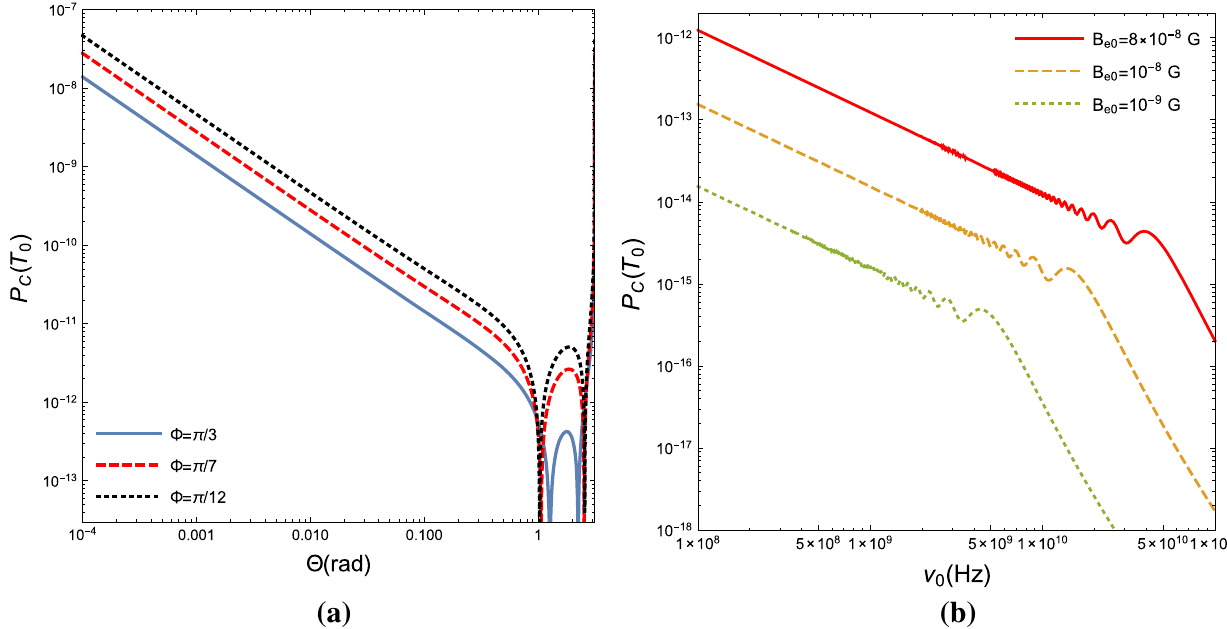
Fig. 7 a Logarithmic scale plots of the degree of circular polarization P C ( T 0 ) given in (66) as a function of (cid:16) ∈ [ 10 − 4 ,π − 10 − 4 ] (rad) for magneticfieldamplitude B e 0 = 8 × 10 − 8 G, frequency ν 0 = 10 8 Hzfor several values of the angle (cid:17) , | r | = 1 and | Q i | = 1 are shown. b Log- arithmic scale plots of the degree of circular polarization P C ( T 0 ) given in (59) (for X e ( T ) (cid:3) ¯ X e = 0 . 023) as a function of ν 0 ∈ [ 10 8 , 10 11 ]